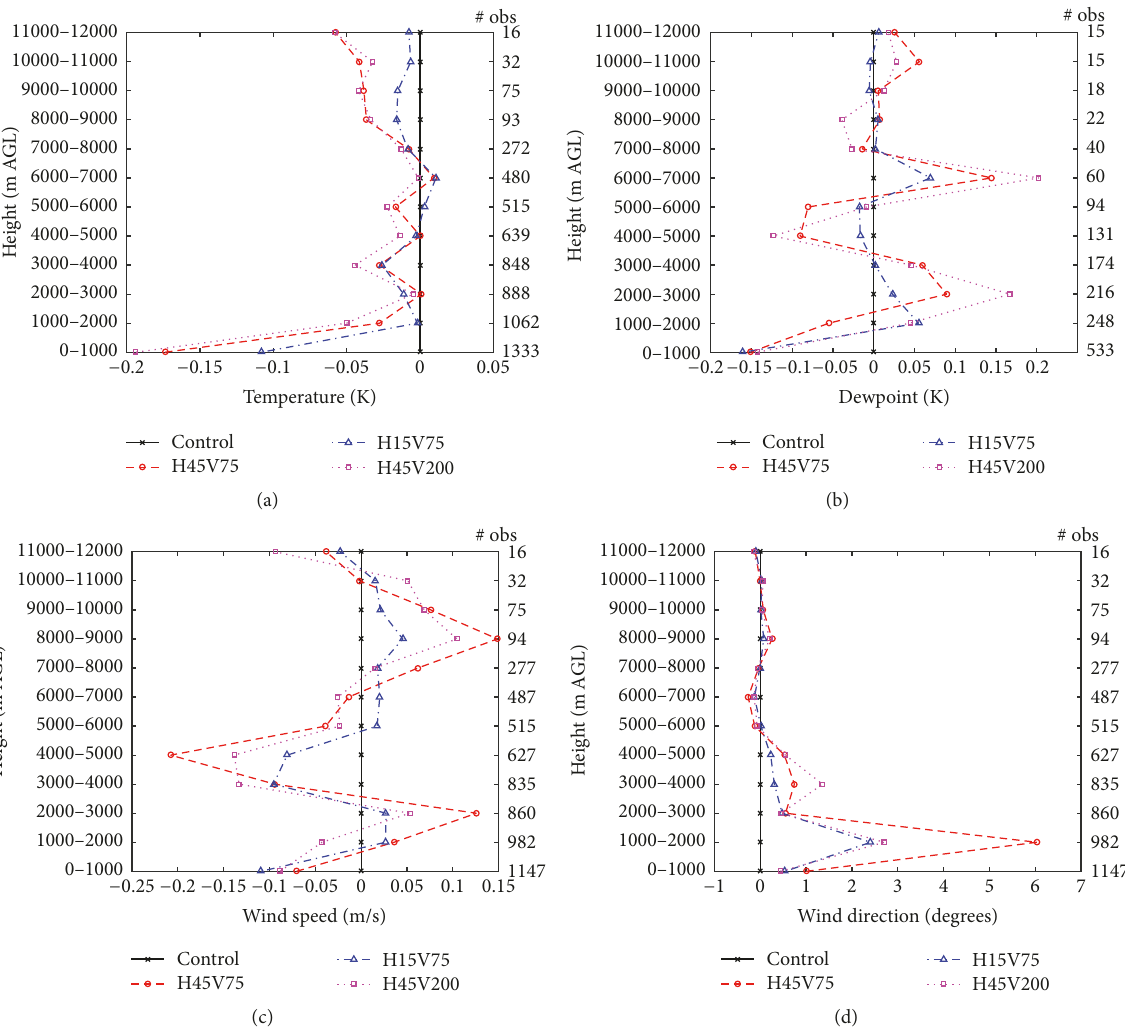
Figure4:VerticalprofilesofthedifferencebetweenMAEforeachexperimentcomparedtotheMAEforExp.Controlforthe1–6 hforecast(19 UTC) as compared to above-surface observations and calculated over observations from all five case days for (a) temperature, (b)